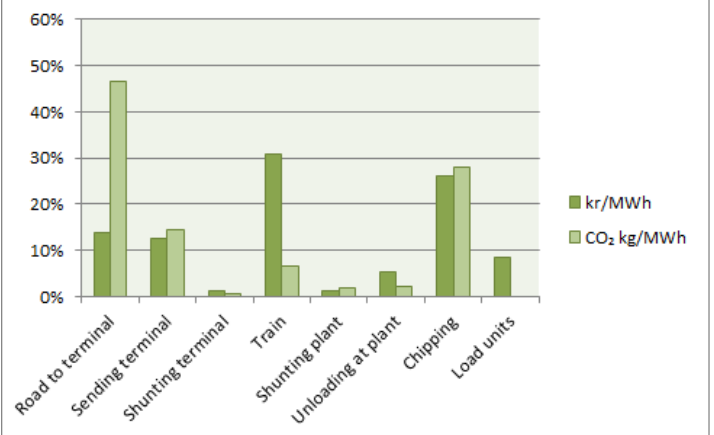
Figure 17. Distribution of costs and CO 2 emissions with intermodal transhipment for 40m 3